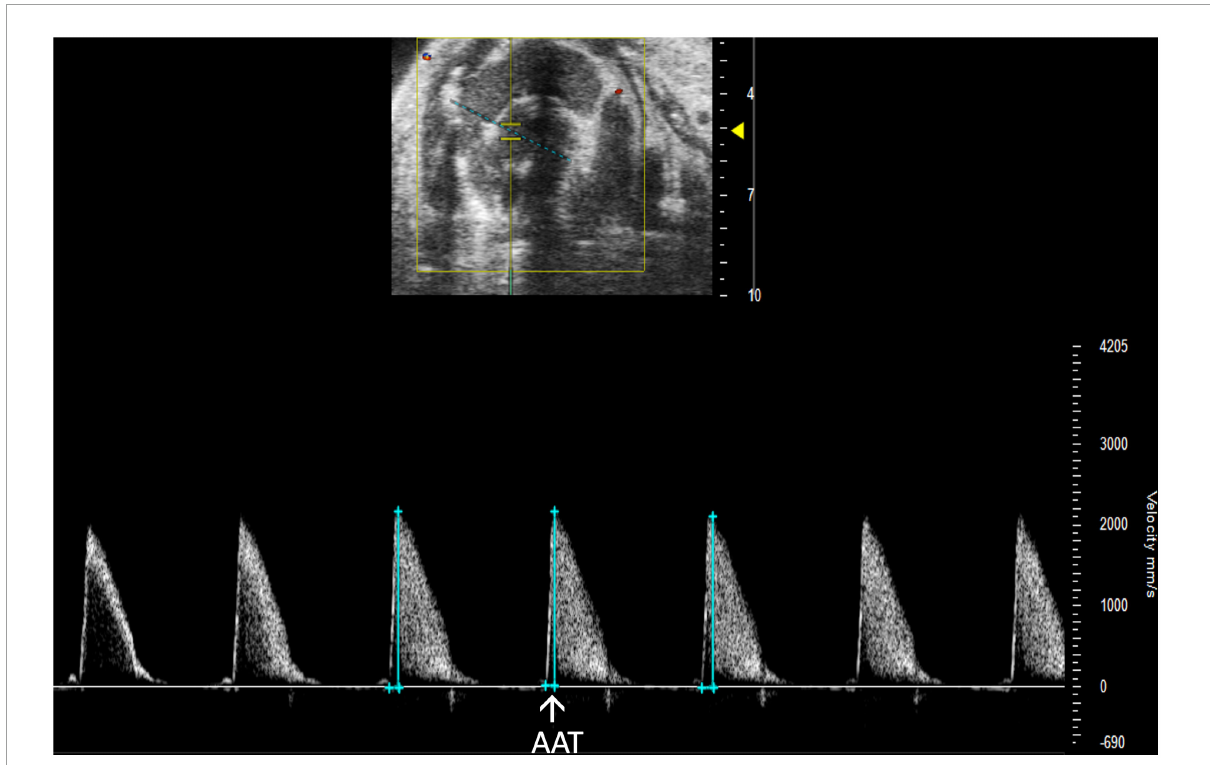
FIGURE14 Pulsed wave (PW) Doppler mode image showing analysis of the aortic acceleration time (AAT), a measurement of left ventricular contractility in